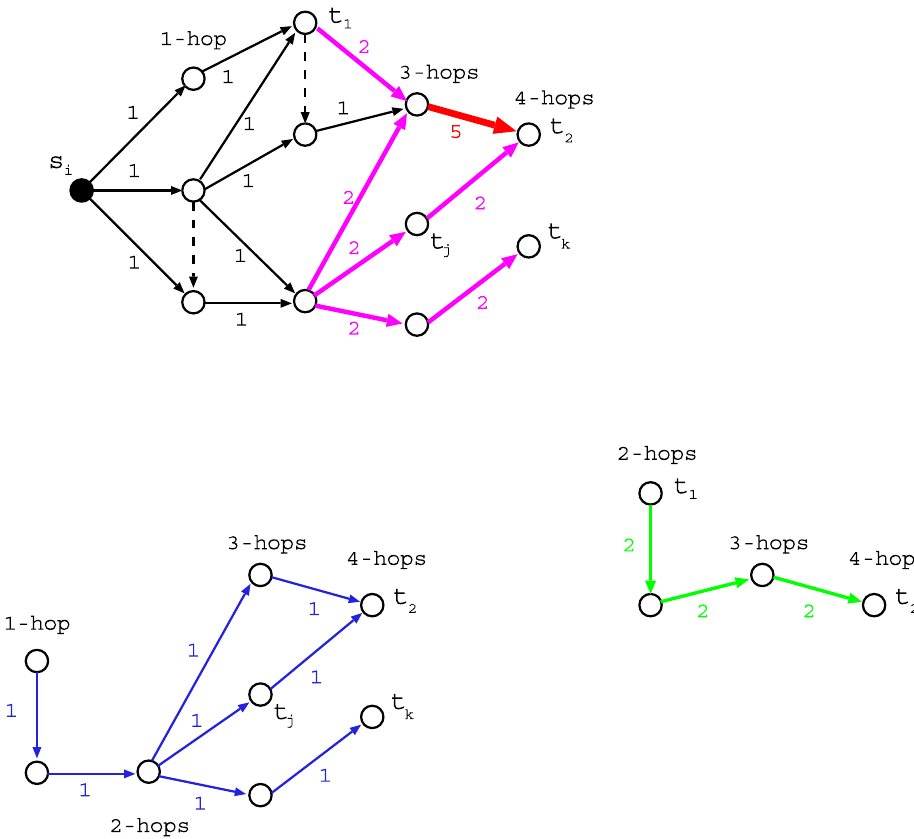
Figure 7. Token-passing from s 1 . (Top) Primary tokens which reach at first the layered vertices by hops. (Bottom-Left) Secondary tokens with a delay of one time-step delivered from the middle vertex on 1-hop layer. (Bottom-Right) Thirdly tokens with a delay of two time-steps delivered from the top vertex on 2-hop layer. The thickness of arrow is corresponding to the number of tokens: 1, 2, or 5. Each element w ij is defined by the sum of primary, secondary, and thirdly tokens reached at the terminal vertices, in this case of i = s 1 and j = t 1 , t 2 , . . . , or t k